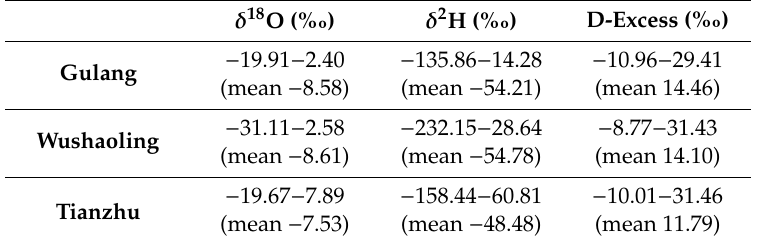
Table 3. Isotopic signatures of precipitation in the Qilian Mountains from 2015 to